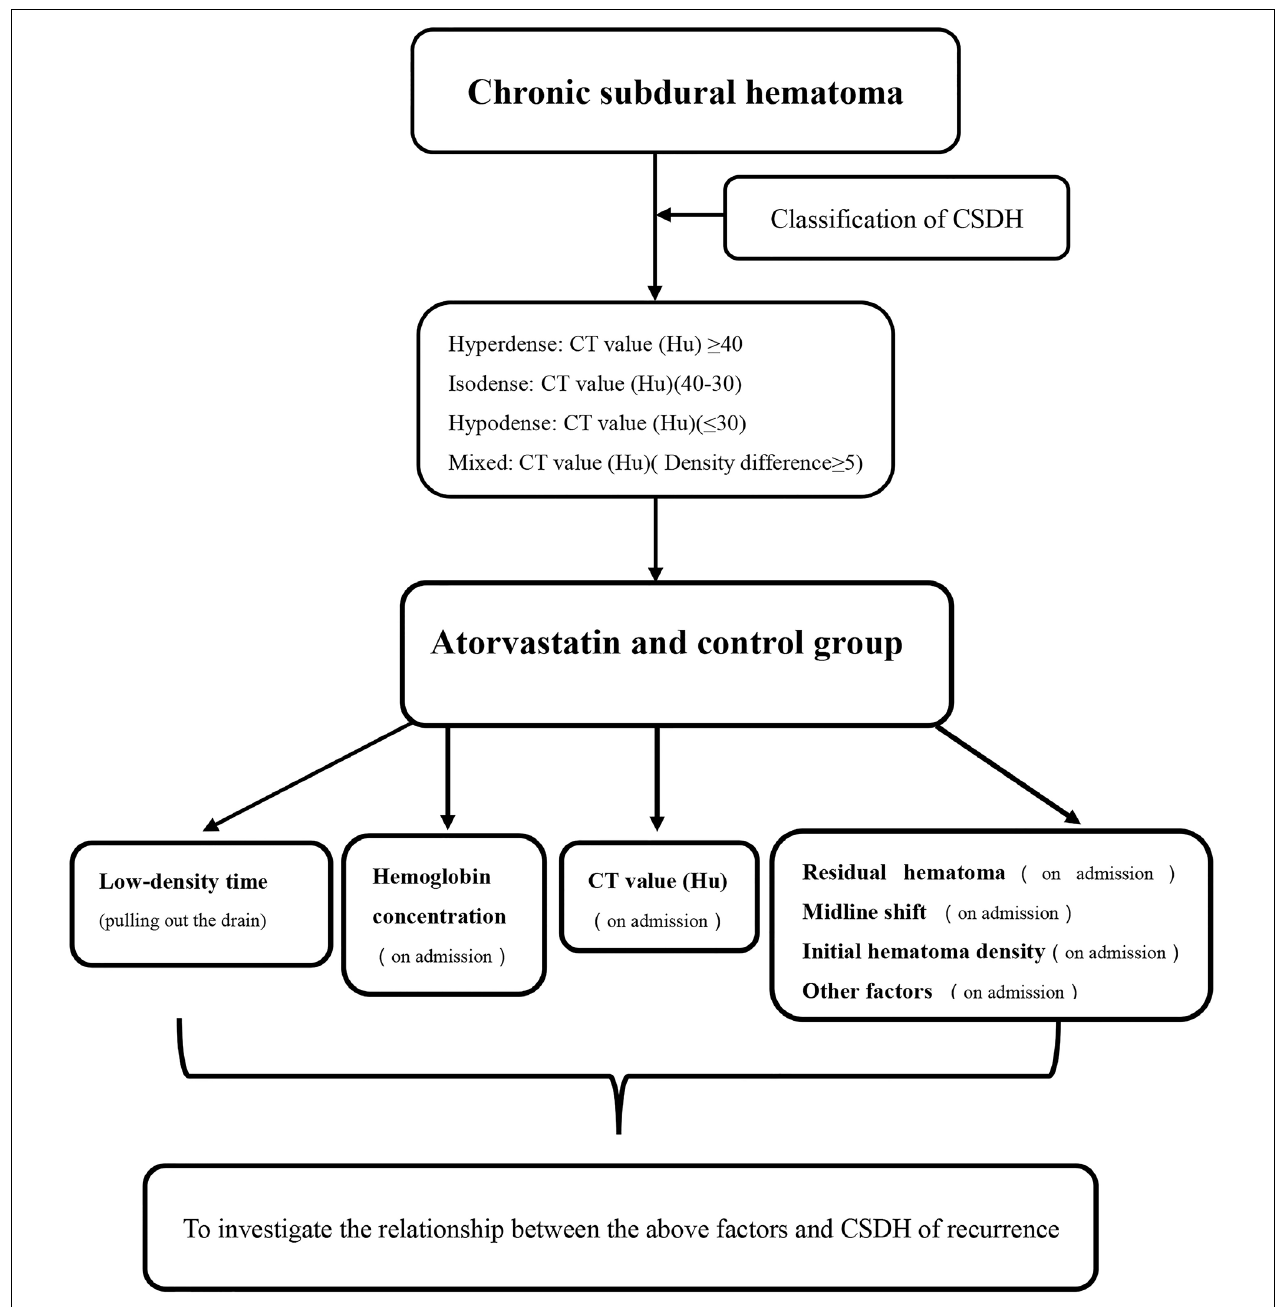
FIGURE 4 | Steps to test the indicators for